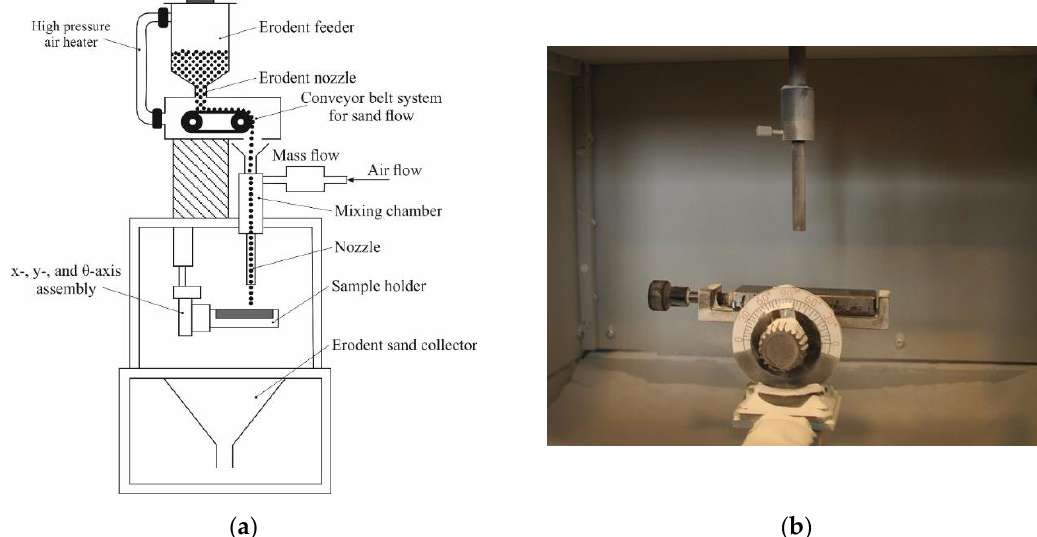
Figure 3. Erosion resistance testing according to ASTM G 76-95 [42]: ( a ) a schematic view, ( b ) the interior view of the erosion measuring chamber .